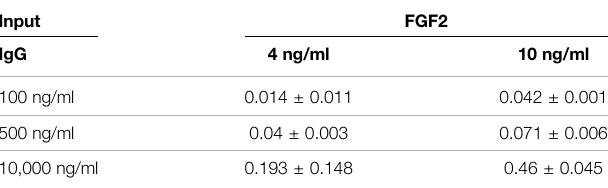
TABLE 1 | Dose-responsive increase in human FGF2 binding to immobilized IgG. Numbers represent mean absorbance (450 nm) and SD values from human FGF2 ELISA. Assays were run in